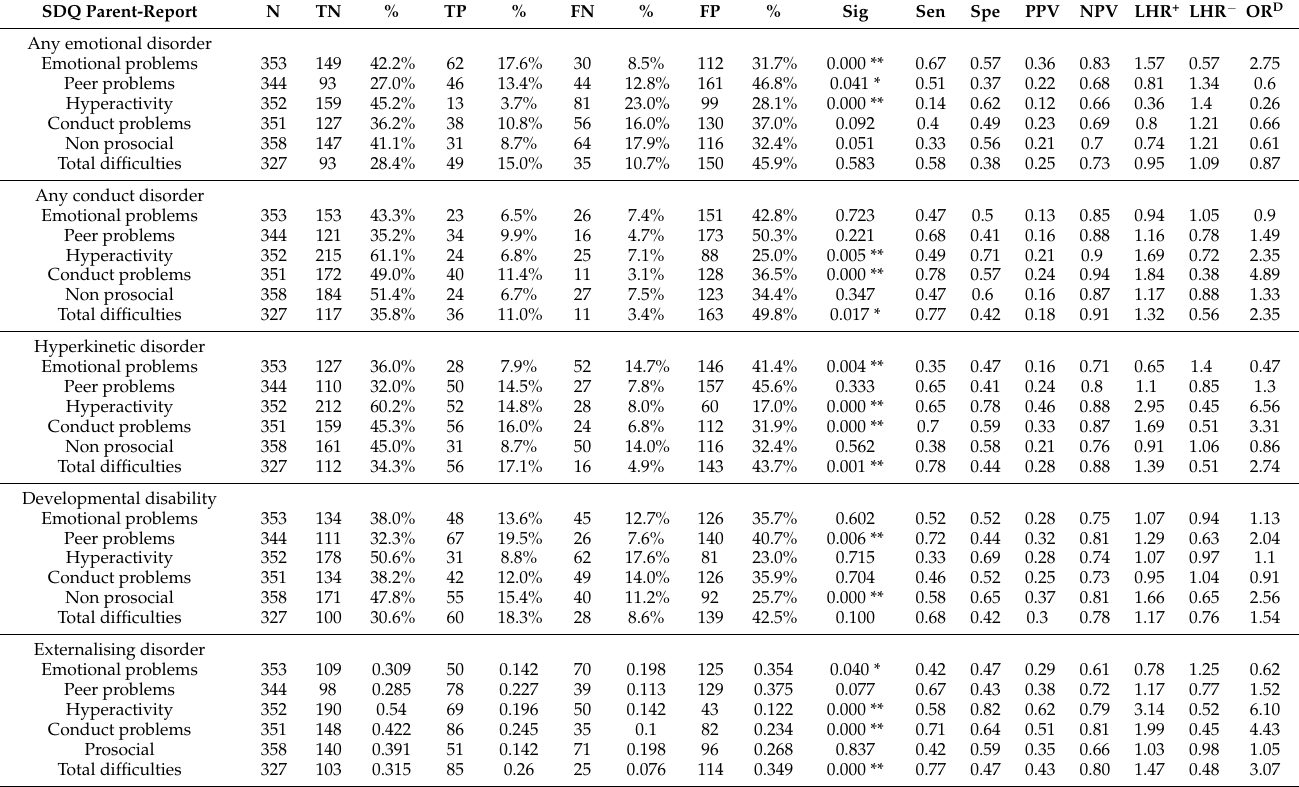
Table 3. Screening efficiency of the parent-report SDQ version subscales for different mental health diagnostic categories in a clinical sample of Latvian children and